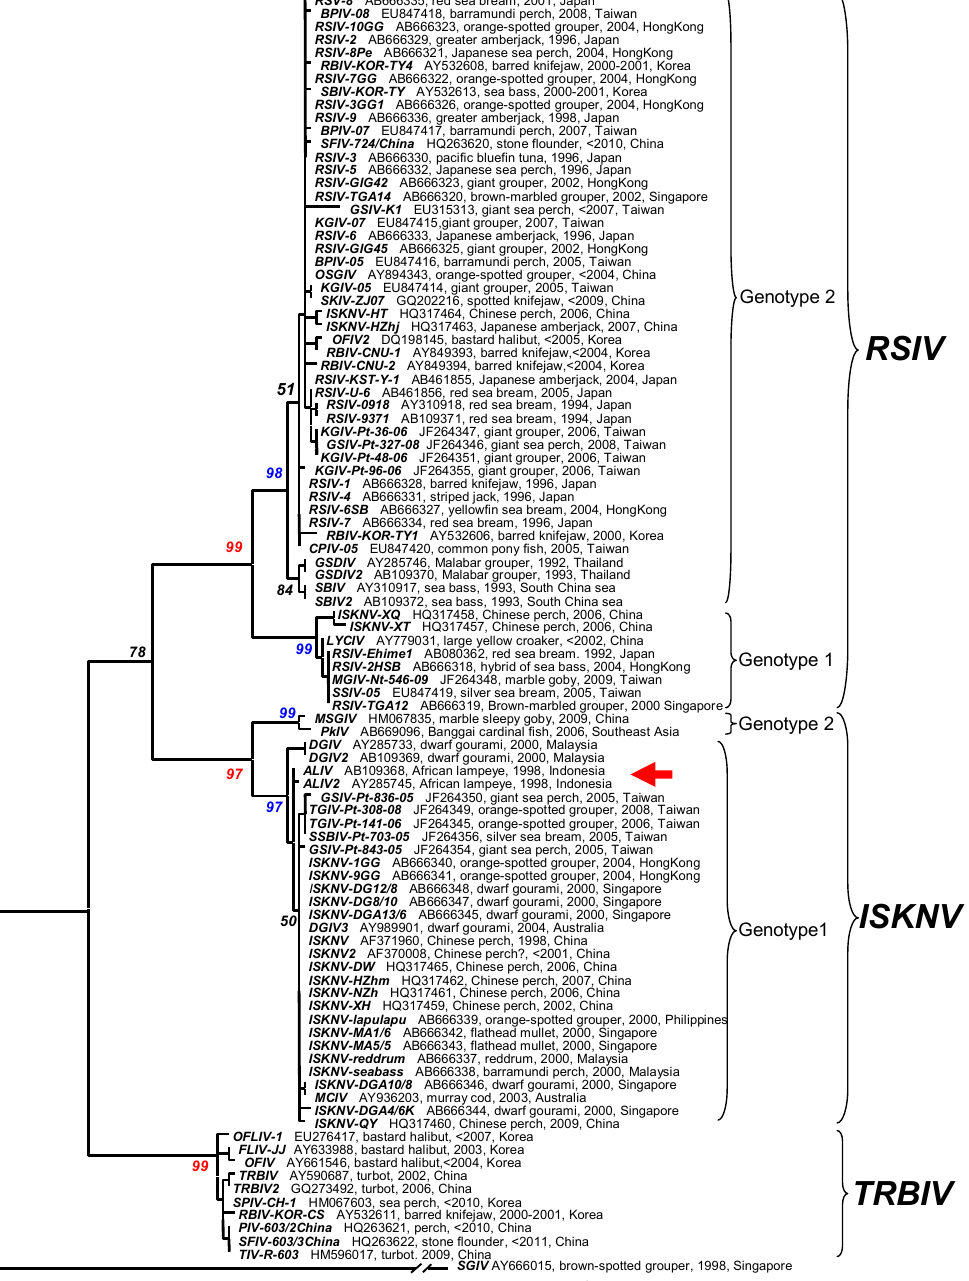
Figure 6. Phylogenetic analysis of the megalocytivirus MCP. The tree was constructed by the neighbor-joining method [43] using MEGA (version 4) [44]. Tamura and Nei’s parameters and pair-wise deletion of gap handling were selected. The numbers indicate the percentage bootstrap support for each node from 1,000 replicates. The tree was rooted using MCP sequences from Singapore grouper iridovirus (SGIV), genus Ranavirus . Stop codons were excluded from the analysis. The red arrow shows the position of African lampeye iridovirus (ALIV). Accession numbers, host, year sampled, and location of isolation are attached to each